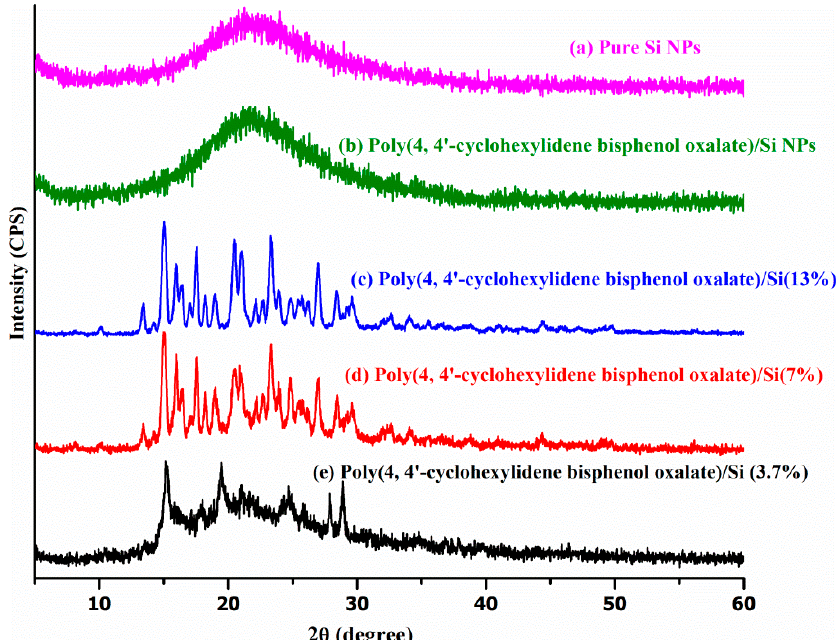
Figure 6. Comparison of the powdered XRD patterns of poly(4,4’-cyclohexylidene bisphenol oxalate), poly(4,4’-cyclohexylidene bisphenol oxalate)/Si(3.7%), poly(4,4’-cyclohexylidene bisphenol oxalate)/Si(7%), poly(4,4’-cyclohexylidene bisphenol oxalate)/Si(13%), and poly(4,4’-cyclohexylidene bisphenol oxalate)/Si sol mixing, along with fumed pure Si. Table 4. Summary of wide-angle XRD peaks, and corresponding d-spacing for the pure Si NPs